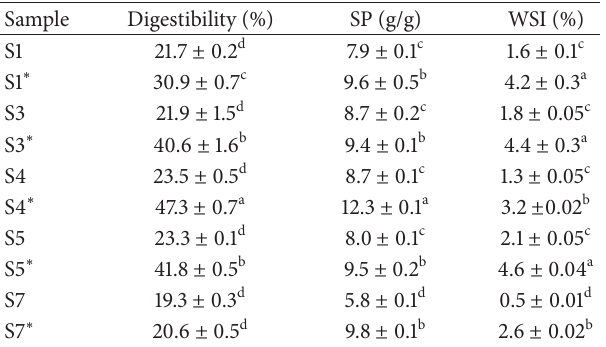
Table 1: Variation in digestibility, SP, and WSI in native starch and ∗ hydroxypropylated